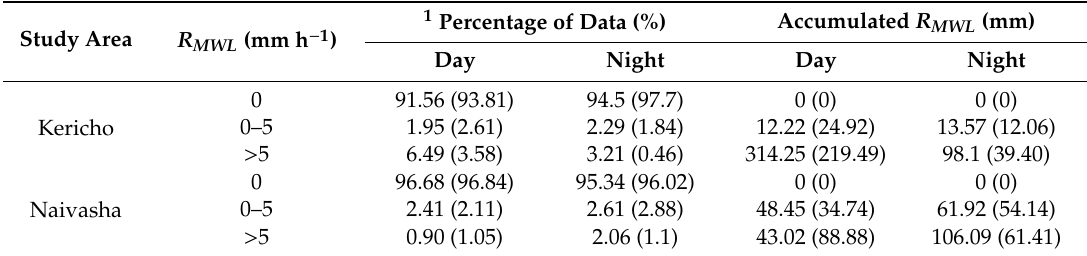
Table 5. Summary of the R MWL data per each study area for the day and